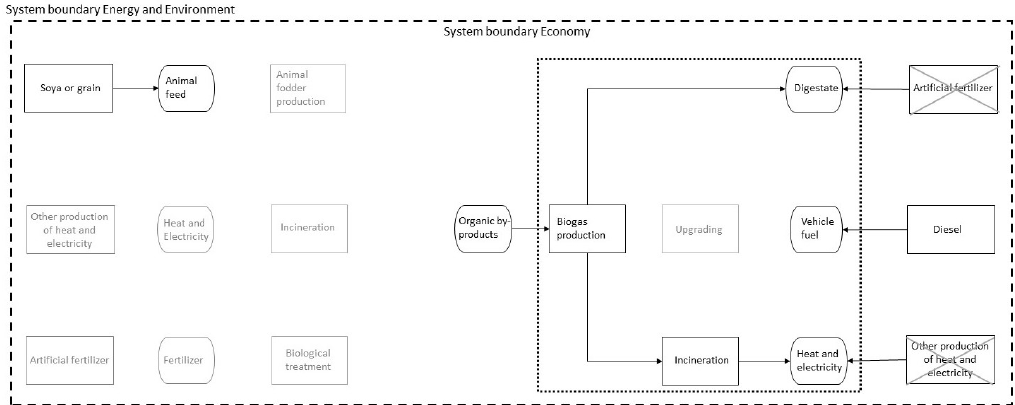
Figure 2. Scenario BAU. The collected by-products are used for either incineration or animal fodder production or are treated biologically. The dotted line shows the system boundary for the economic perspective and the crosshatched line shows the system boundary for the energy and environmental perspectives. The boxes in grey are not included in the scenario and the crossed boxes are the alternative treatment methods replaced.